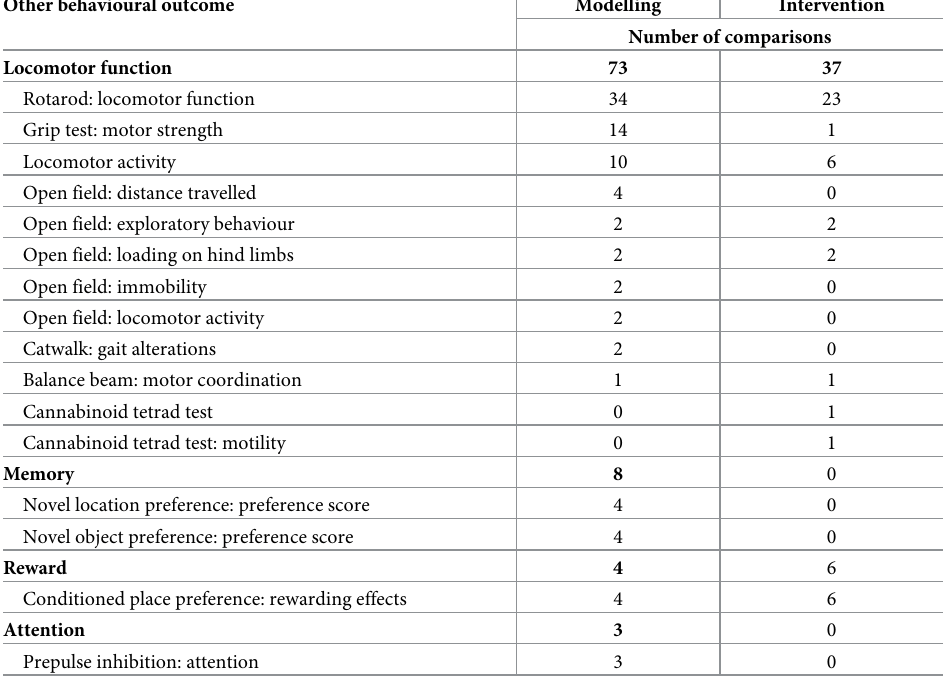
Table 2. Other behavioural outcome measures across intervention and modelling experiments. Number of indi- vidual